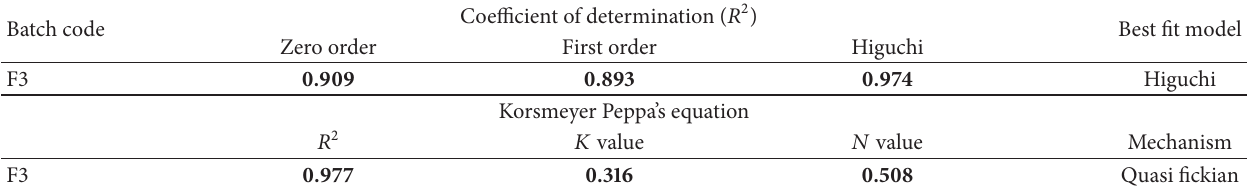
Table 6: Model fitting of the release profile using four different models.